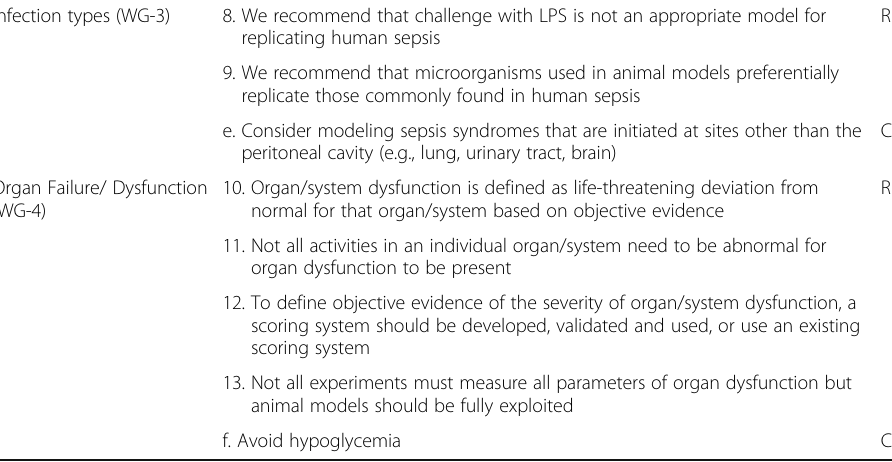
Table 2 Combined recommendations and considerations from the working groups (WG) 3 and 4 Infection types (WG-3)